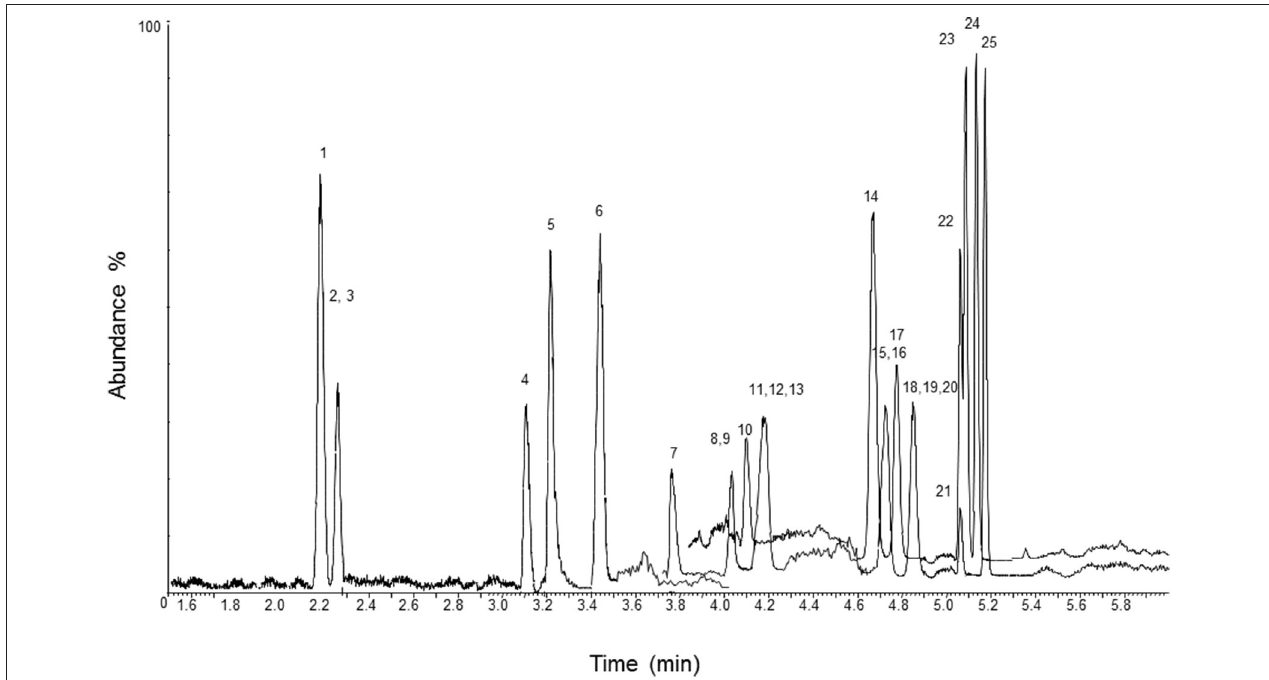
FIGURE 2 | LC-MS/MS chromatogram of a urine sample fortified with the analytes at the limit of quantification and their ISs. 1, methoxyacetyl norfentanyl; 2, acetyl norfentanyl; 3, acetyl norfentanyl-D5; 4, norfentanyl; 5, furanyl norfentanyl; 6, cyclopropyl norfentanyl; 7, butyryl norfentanyl; 8, butyrylfentanyl carboxy metabolite; 9, methoxyacetylfentanyl; 10, β -hydroxythiofentanyl; 11, valerylfentanyl carboxy metabolite; 12, furanylethyl fentanyl; 13, acetylfentanyl; 14, fentanyl; 15, fentanyl-D5; 16, despropionylfentanyl (4-ANPP); 17, alfentanil; 18, furanylfentanyl; 19, despropionyl para -fluorofentanyl; 20, cyclopropylfentanyl; 21, carfentanil; 22, butyrylfentanyl;